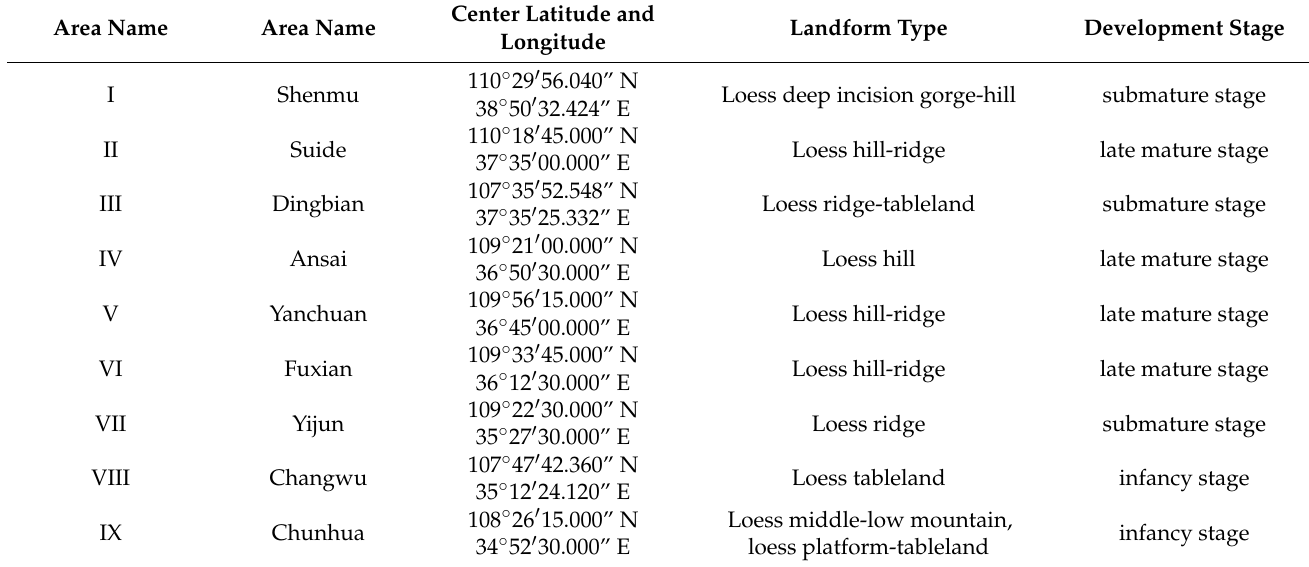
Figure 1. Location of the Loess Plateau and the distribution of the test sites. Table 1. The typical sample area of nine loess